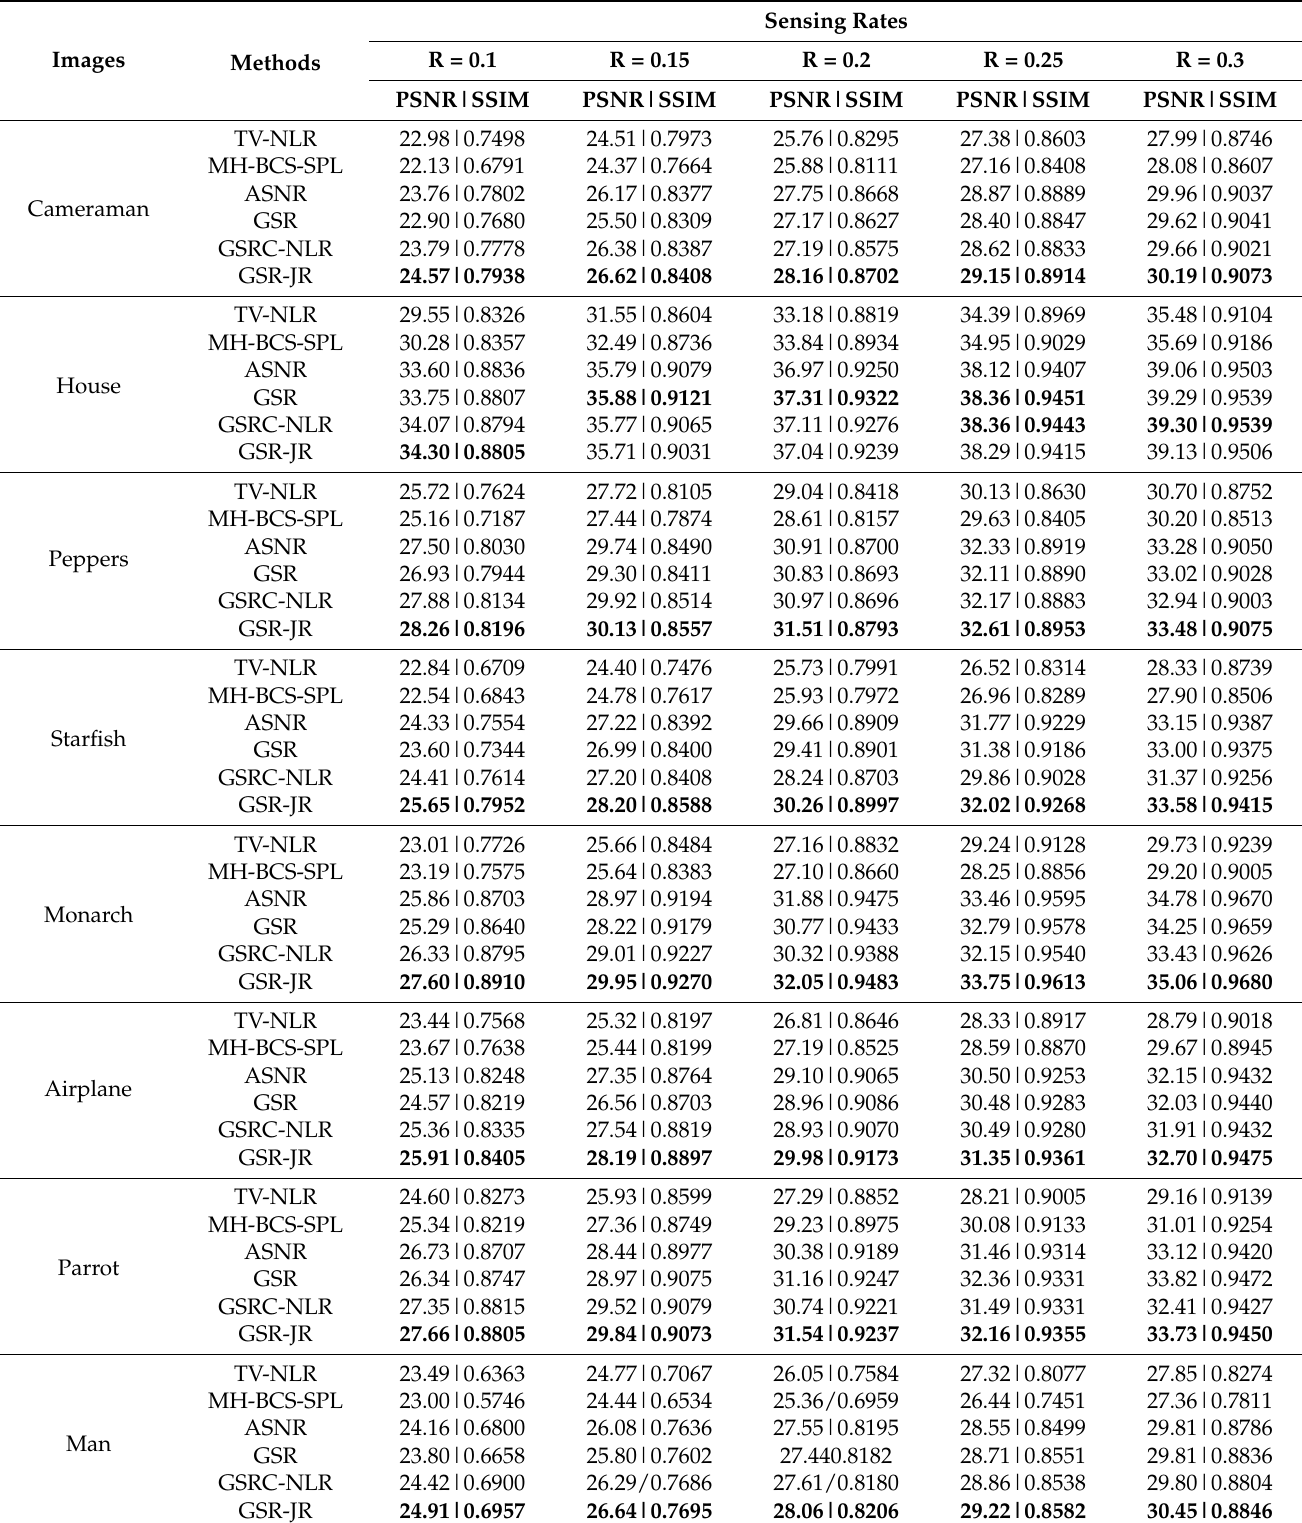
Table 2. The PSNR (dB) and SSIM of six image reconstruction models at various sensing